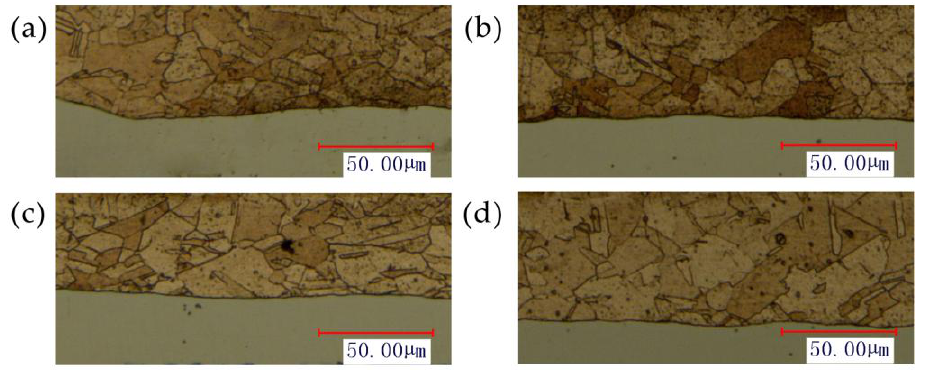
Figure 23. The microstructure at 1800 mJ and different temperature: ( a ) 25 ◦ C, ( b ) 100 ◦ C, ( c ) 175 ◦ C and ( d ) 250 ◦ C.